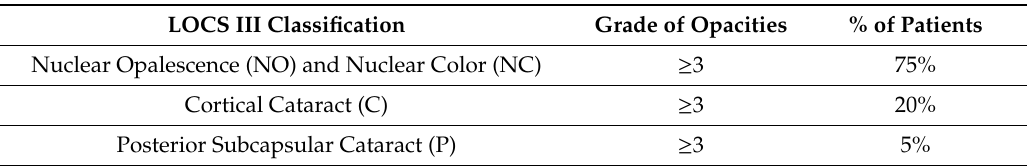
Table 1. Cataract grade of patients, according to Lens Opacities Classification System (LOCSIII) classification, included in the study. All treated cataracts were cortical / nuclear, as it is di ffi cult to provide a clear distinction between